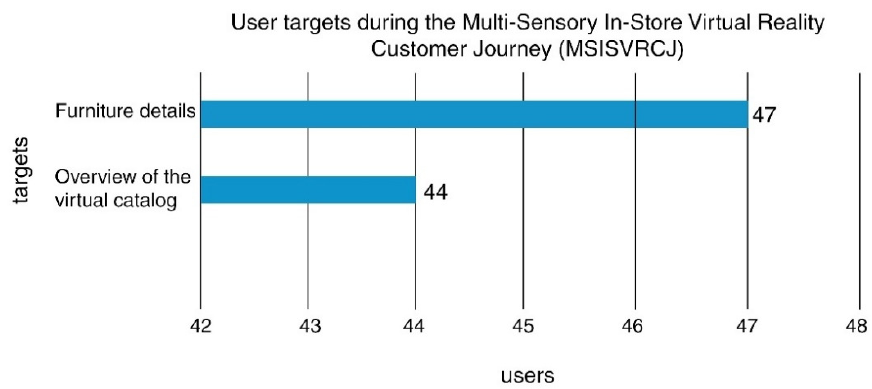
Figure 7. User targets during the Multi-Sensory In-Store Virtual Reality Customer Journey.